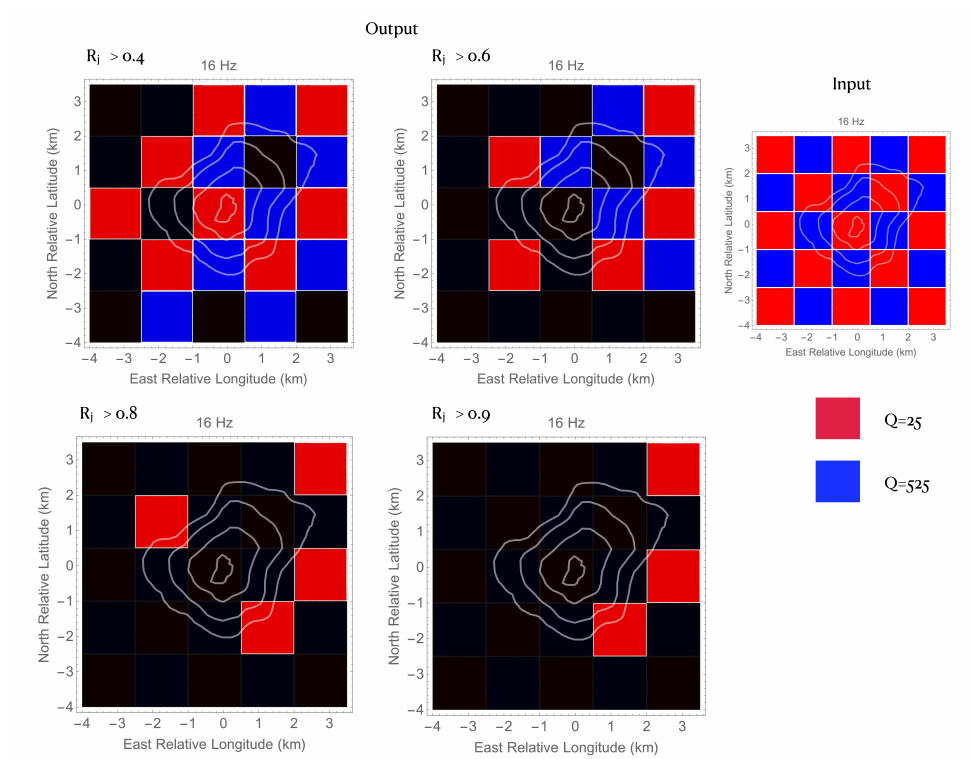
Figure 12. The same of Figure 11 for the space fluctuations of Q − 1 s . .